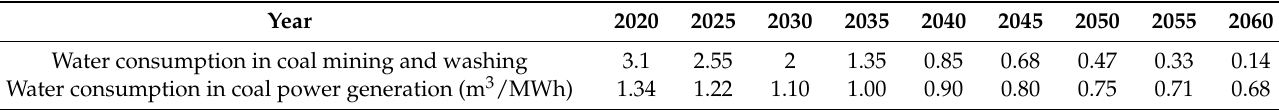
Table 6. Prediction of the future trend in water consumption